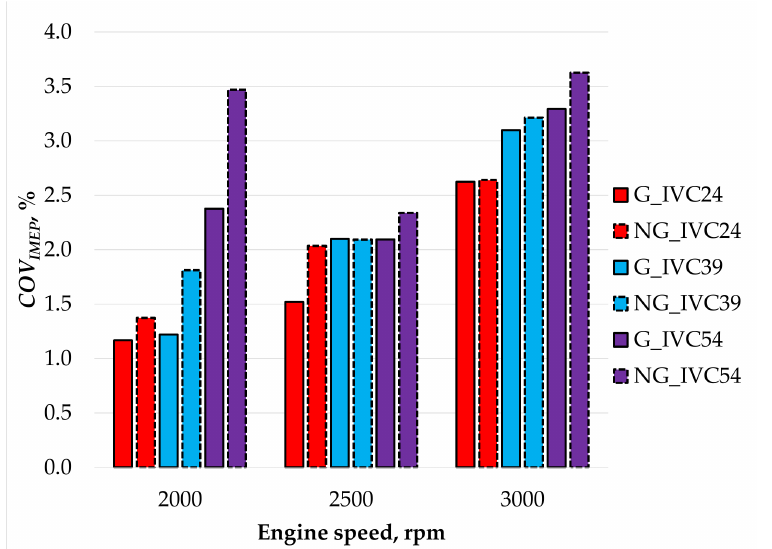
Figure 12. Indicated mean effective pressure variation engine running on gasoline and natural gas and while changing the intake valve close